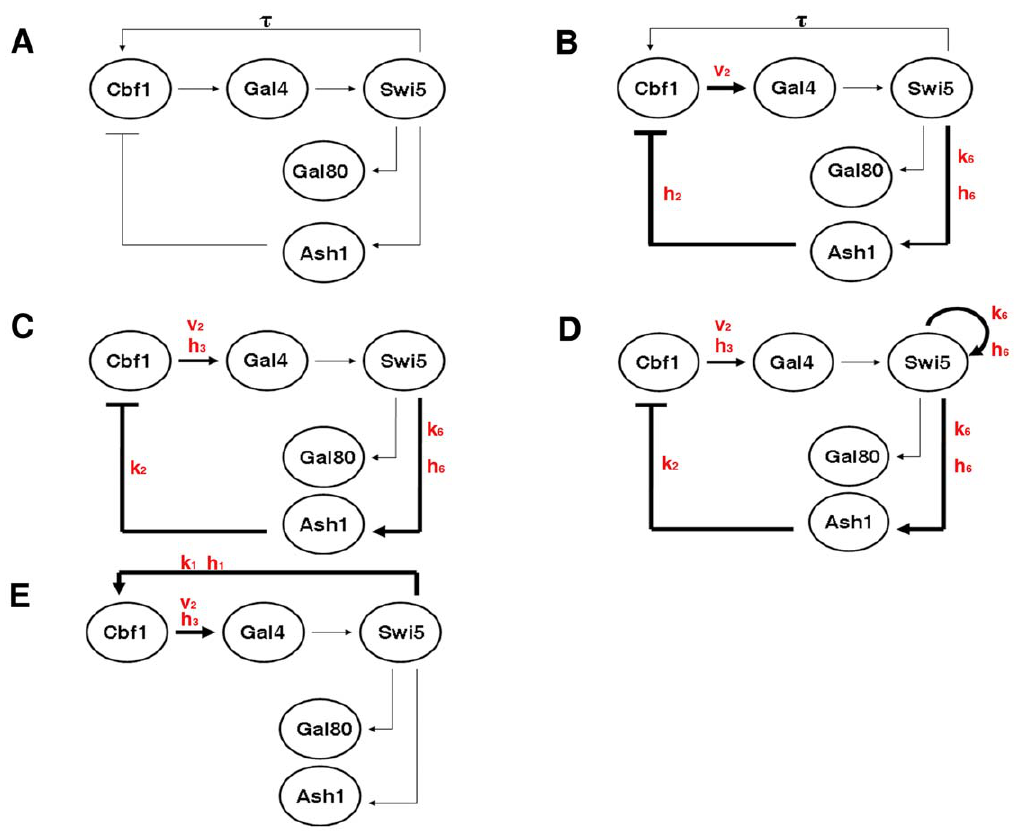
Figure 1. Re-engineering the topology in order to turn IRMA into an oscillator or a switch. Comparison between the topology of the actual version of the network (A) and the re-engineered topologies (B)–(E); in all the cases we only consider the galactose growing condition. A thicker line corresponds to an increase of the strength of the corresponding interaction; the strength is intended in terms of Michaelis-Menten coefficient and/or Hill coefficient and/or maximal transcriptional velocity. The parameters in red are the ones that we are varying from the nominal value. (A) Topology of IRMA. In galactose growing conditions, the topology consists of one delayed positive and one negative feedback loop, since the protein-protein interaction between Gal4 and Gal80 is switched off. (B) Re-engineering of IRMA in order to turn it into an autonomous oscillator, Scenario 1. Tuning the parameters v 2 , k 6 , h 2 and h 6 we increase the strength of the following interactions: Cbf1 on Gal4, Swi5 on Ash1 and Ash1 on Cbf1. Both the original positive and the negative feedback lops are present. (C) Re-engineering of IRMA in order to turn it into an autonomous oscillator, Scenario 2. Tuning the parameters v 2 , k 1 , k 2 , k 6 , h 3 and h 6 we increase the strength of the following interactions: Cbf1 on Gal4, Swi5 on Ash1 and Ash1 on Cbf1. The original positive feedback loop is removed. (D) Re-engineering of IRMA in order to turn it into an autonomous oscillator, Scenario 3. The topology is identical to the one in Scenario 2 with the addition of a positive auto-feedback-loop on Swi5. The tuned parameters are: v 2 , k 1 , k 2 , k 6 , h 3 and h 6 . (E) Re-engineering of IRMA in order to turn it into a bistable switch, Scenario 4. Properly tuning the parameters v 2 , k 1 , k 2 , h 1 and